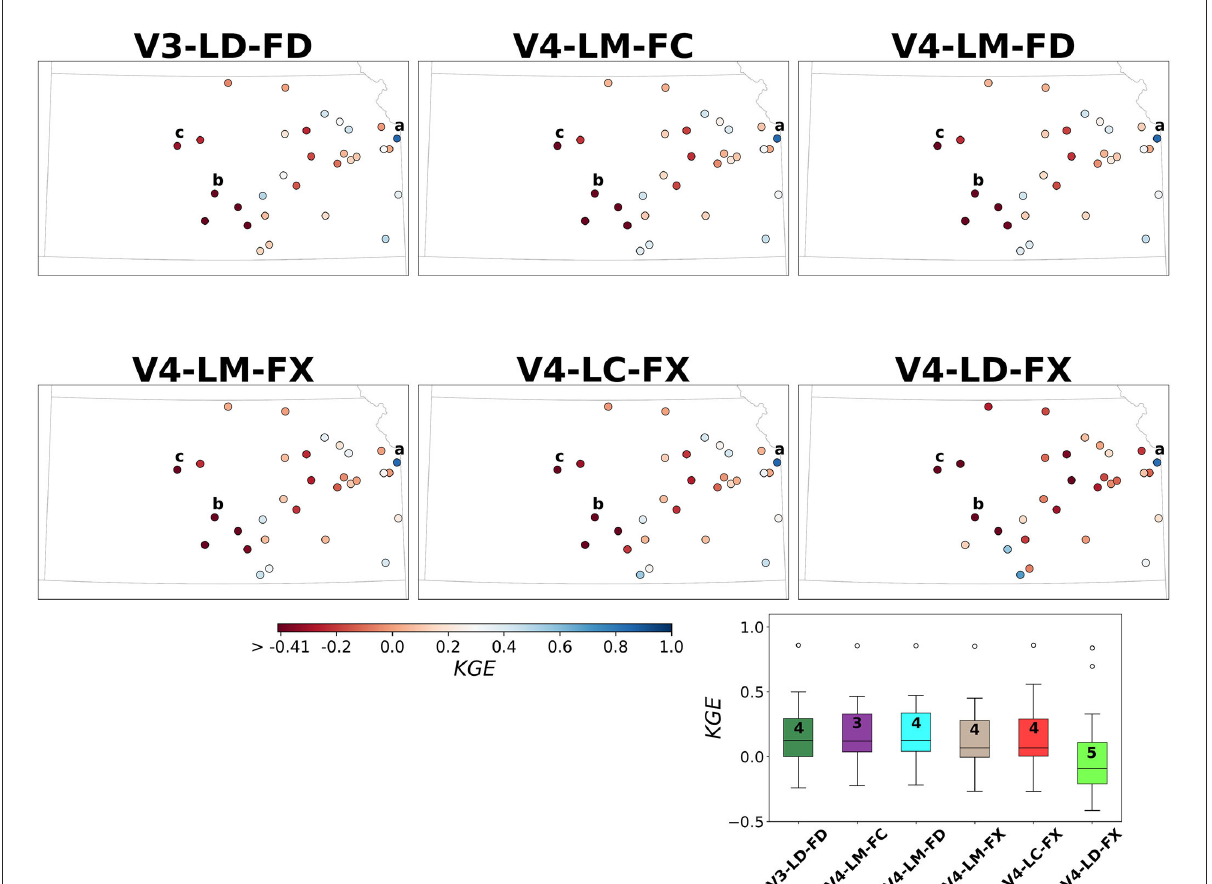
FIGURE9 Map of streamflow prediction performance using KGE for 31 selected basins across the model domain, and boxplots of each model configuration with the range from 0.41 to 1. The numbers on the boxplots represent the total number of the gauges below the minimum KGE − benchmark value ( 0.41). Locations of USGS gauges with maximum (a), minimum (b), and minimum threshold (c) average KGE in this figure are − marked on the